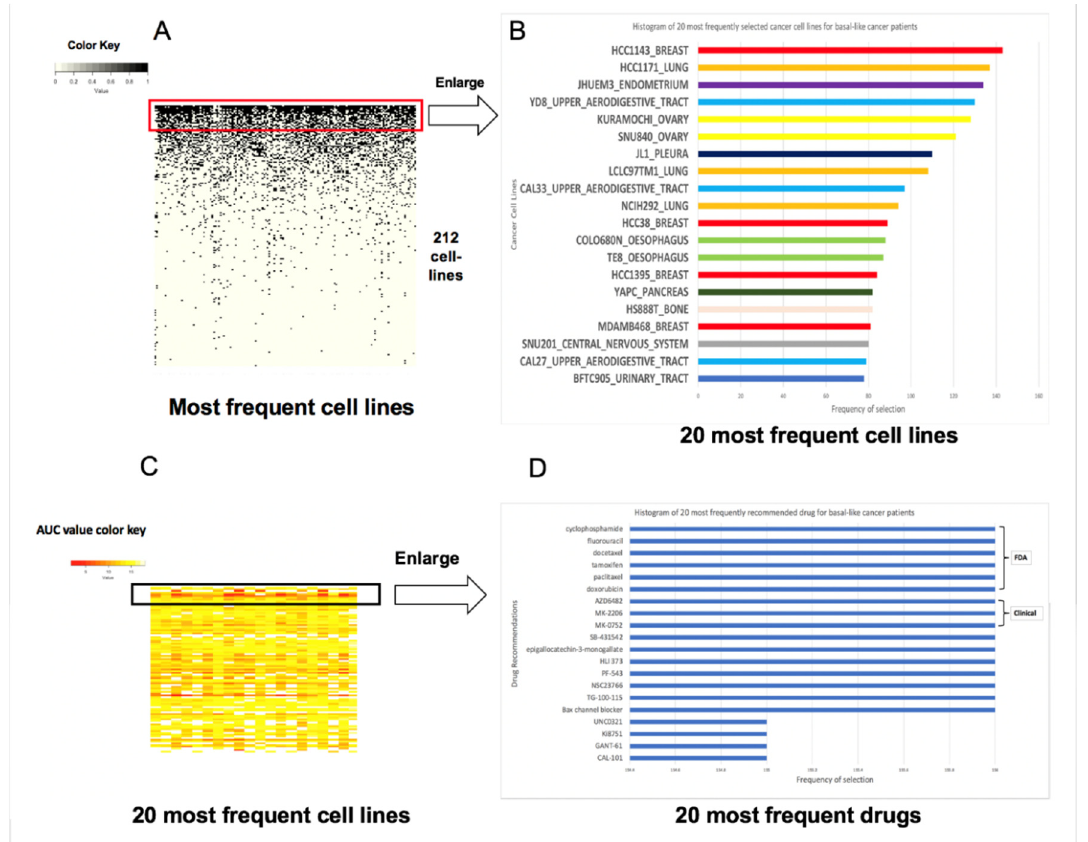
Figure 2. The most frequently occurring cancer cells and recommended drugs to 156 basal like patients with breast cancer. ( A ) The distribution of the different cell lines selected by our method for patients with basal like breast cancer. The X-axis contains the different patients while the Y-axis consists of the different cancer cell lines. The cell lines were sorted based on the frequency of their selection in descending order. ( B ) An enlargement of the top 20 cancer cell lines with the highest frequency. ( C ) A heatmap distribution of the drugs for basal like cancer patients based on area under the curve (AUC) values. The X-axis is the cancer cell lines that are selected from these patients and the Y-axis is the different recommended drugs. ( D ) A frequency depiction of the top 20 recommended drugs to these patients.